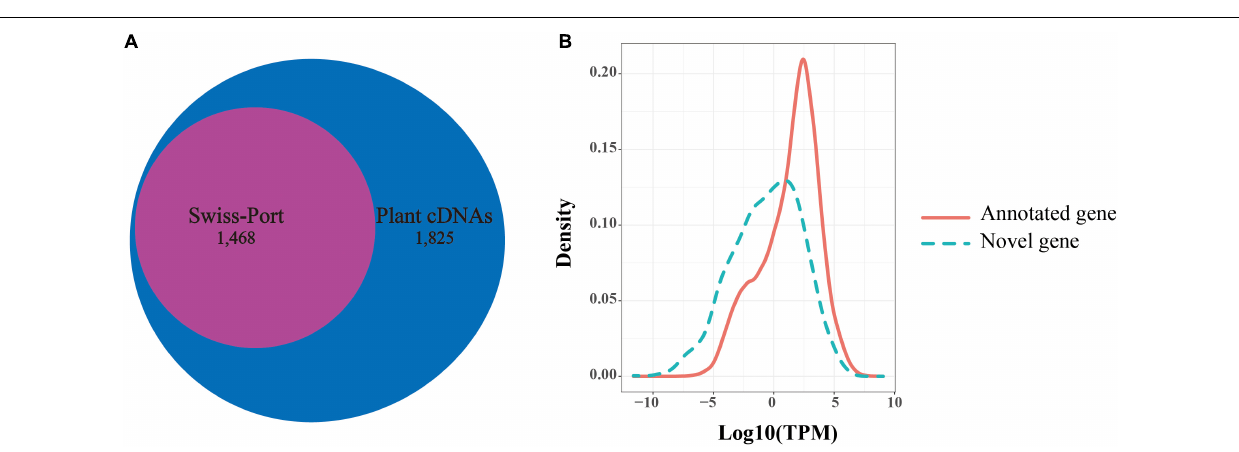
FIGURE 4 | Novel genes identified in Iso-Seq data. (A) The number of novel genes in B. rapa that showed significant sequence similarity in a blastx search against Swiss-Prot proteins or in a tblastx search against plants cDNAs. (B) Distributions of transcripts per million (TPM) values of novel genes (green dotted line) and annotated genes (red